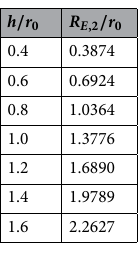
Table 1. Interlayer distances h / r 0 and classical turning points R E ,2 / r 0 for a two-body system in a dipolar